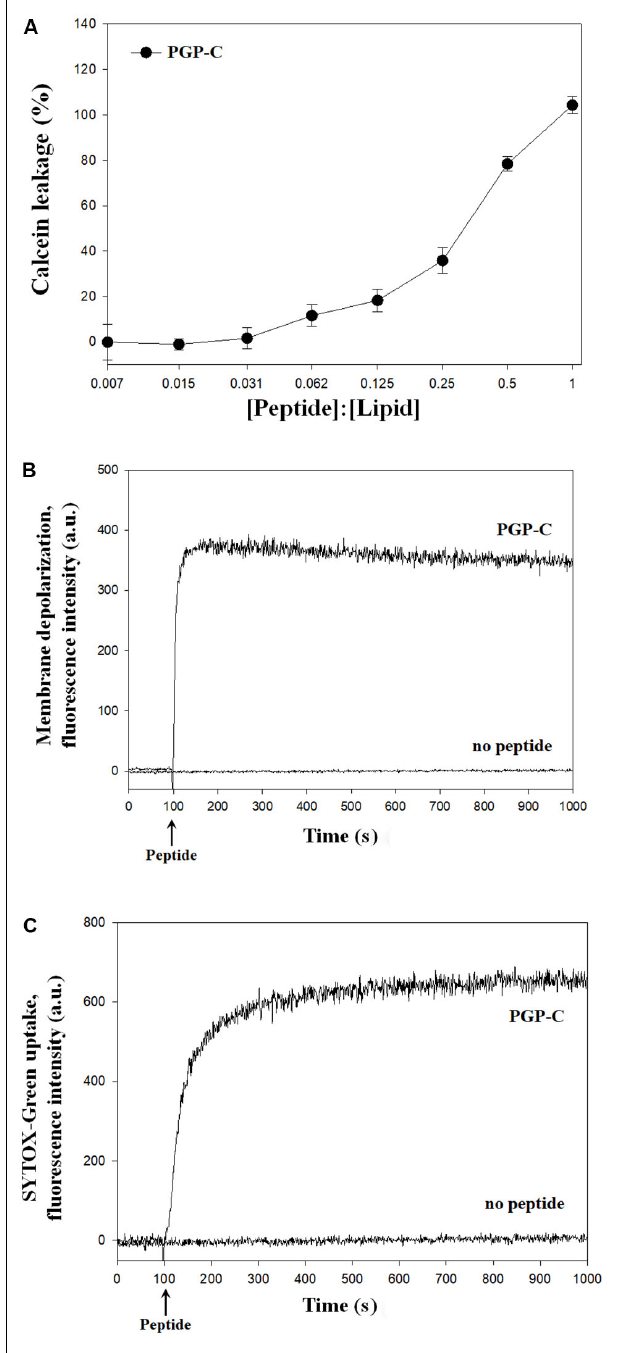
FIGURE 3 | The mechanism studies of pelgipeptin (PGP)-C using calcein leakage (A) , membrane depolarization (B) , and SYTOX-Green uptake (C) experiments. For calcein leakage, PGP-C was added to calcein encapsulated large unilamellar vesicles (LUVs) at different peptide:lipid ratios. Each value represents the mean ± standard deviation ( n = 3) of two runs, with three replicates each. The depolarization of the X. oryzae pv. oryzae cytoplasmic membrane was induced by the PGP-C peptide at 8 µ g/ml concentration. The alterations of the cytoplasmic membrane of X. oryzae pv. oryzae by PGP-C (8 µ g/ml) allowed the SYTOX Green probe to enter the cell and bind DNA, resulting in an increase of